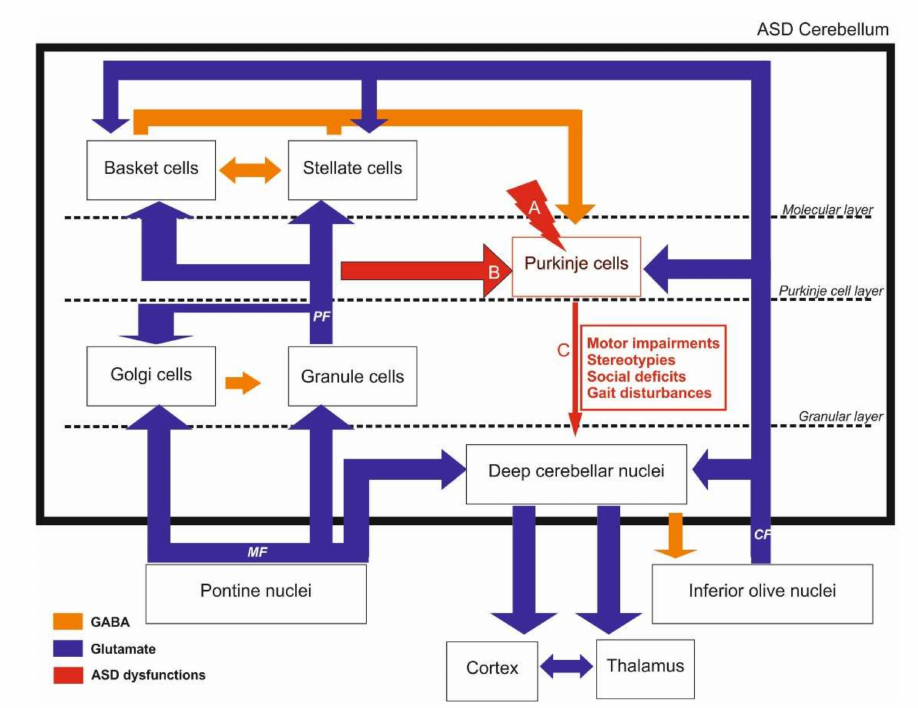
Figure 1. The cerebellum is involved in both motor and social impairments reported in ASD. Dys- functional Purkinje cells (PC) seem to be at the center of these impairments as they represent the sole output of the cerebellum and receive inputs from both inhibitory and excitatory cells. PC dysfunctions are reported in ASD clinical settings and in animal models (A, B, C). PC intrinsic changes (A) such as reduced PC density was shown in Fmr1 KO mice [44], TSC2f/- mice [45], Mecp2 deficient mice [46], VPA mice [47], polyI:C mice [48] and Shank3 ∆ C/ ∆ C mice [49], with regional lobular differences between males and females. Low PC numbers associated with a decrease in soma size and an increase in ectopic PC number were also reported in VPA rats [50], especially in lobule VII hemispheres (crus I and II) that are involved in sensorimotricity. Impaired inputs from granule cells through parallel fibers (B) were also reported. For instance, the mGluR-long term depression (LTD) was altered at the PF-PC synapse in both PC-specific Grip1/2 KO mice and Fmr1 KO mice [51,52]). Furthermore, PC abnormal dendritic branching and reduced density of dendritic spines were found to impair synapse formation in VPA rats [53,54] and in Fmr1 KO mice [44,51]. Outputs from PC onto deep cerebellar nuclei (C) are also impacted, as PC firing pattern is impaired in mice lacking Calbindin, with decreased complex spike duration and pause, as well as decreased simple high spike firing rate [55]. In the Shank2 KO mice, an increased irregularity in simple spike PC firing accompanied by increased inhibition was only found in the posterior cerebellum [56]. Altogether, these PC-focused alterations would lead to dysfunctional cerebellar loop up to the thalamus and cortex leading to both motor and cognitive impairments. MF: Mossy fibers, CF: climbing fibers, PF: parallel